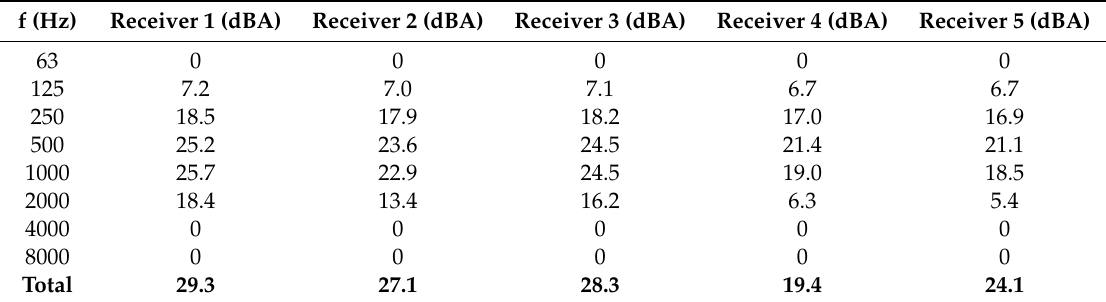
Table A2. Octave-band SPL for each receiver at the Llumeres location using the ISO standard. f (Hz)